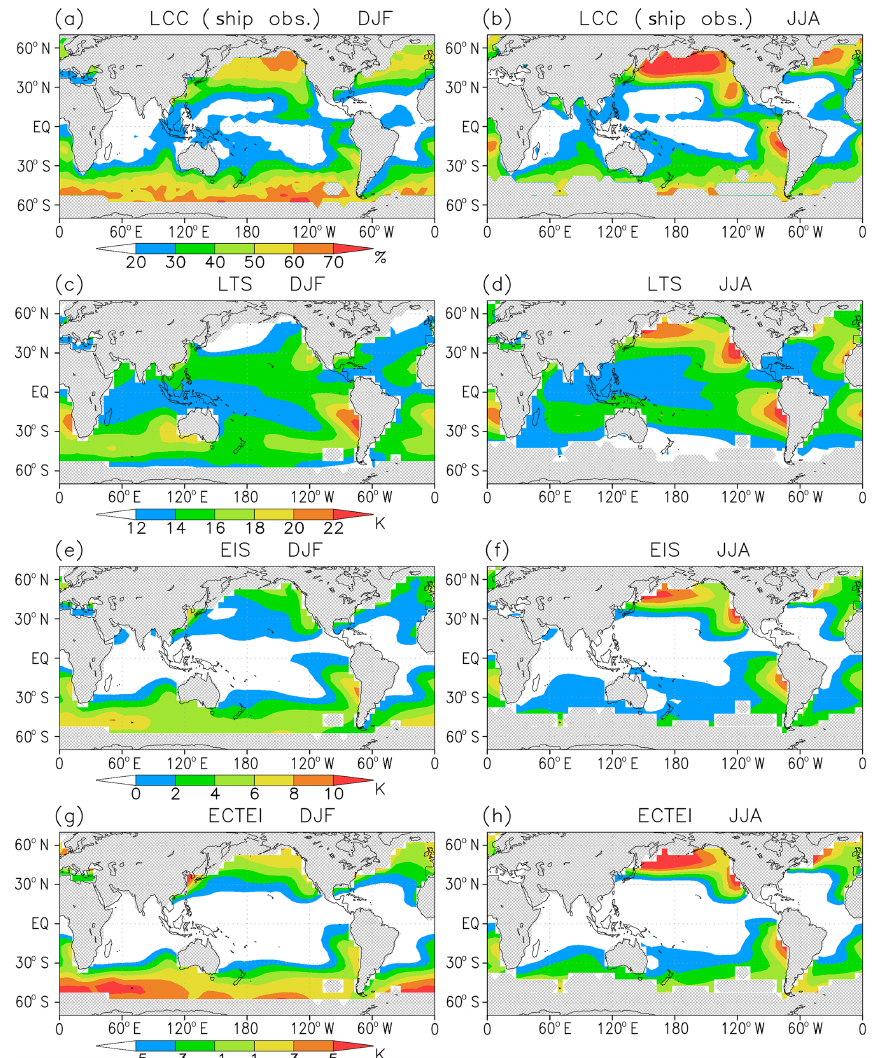
Figure 12. Climatologies of low stratiform cloud cover (%), LTS (K), EIS (K) and ECTEI (K) for December to February (a, c, e, g) and June to August (b, d, f, h) . Cloud cover data were obtained from EECRA shipboard observations, and stability indexes were calculated using ERA-40 data (1957–2002).